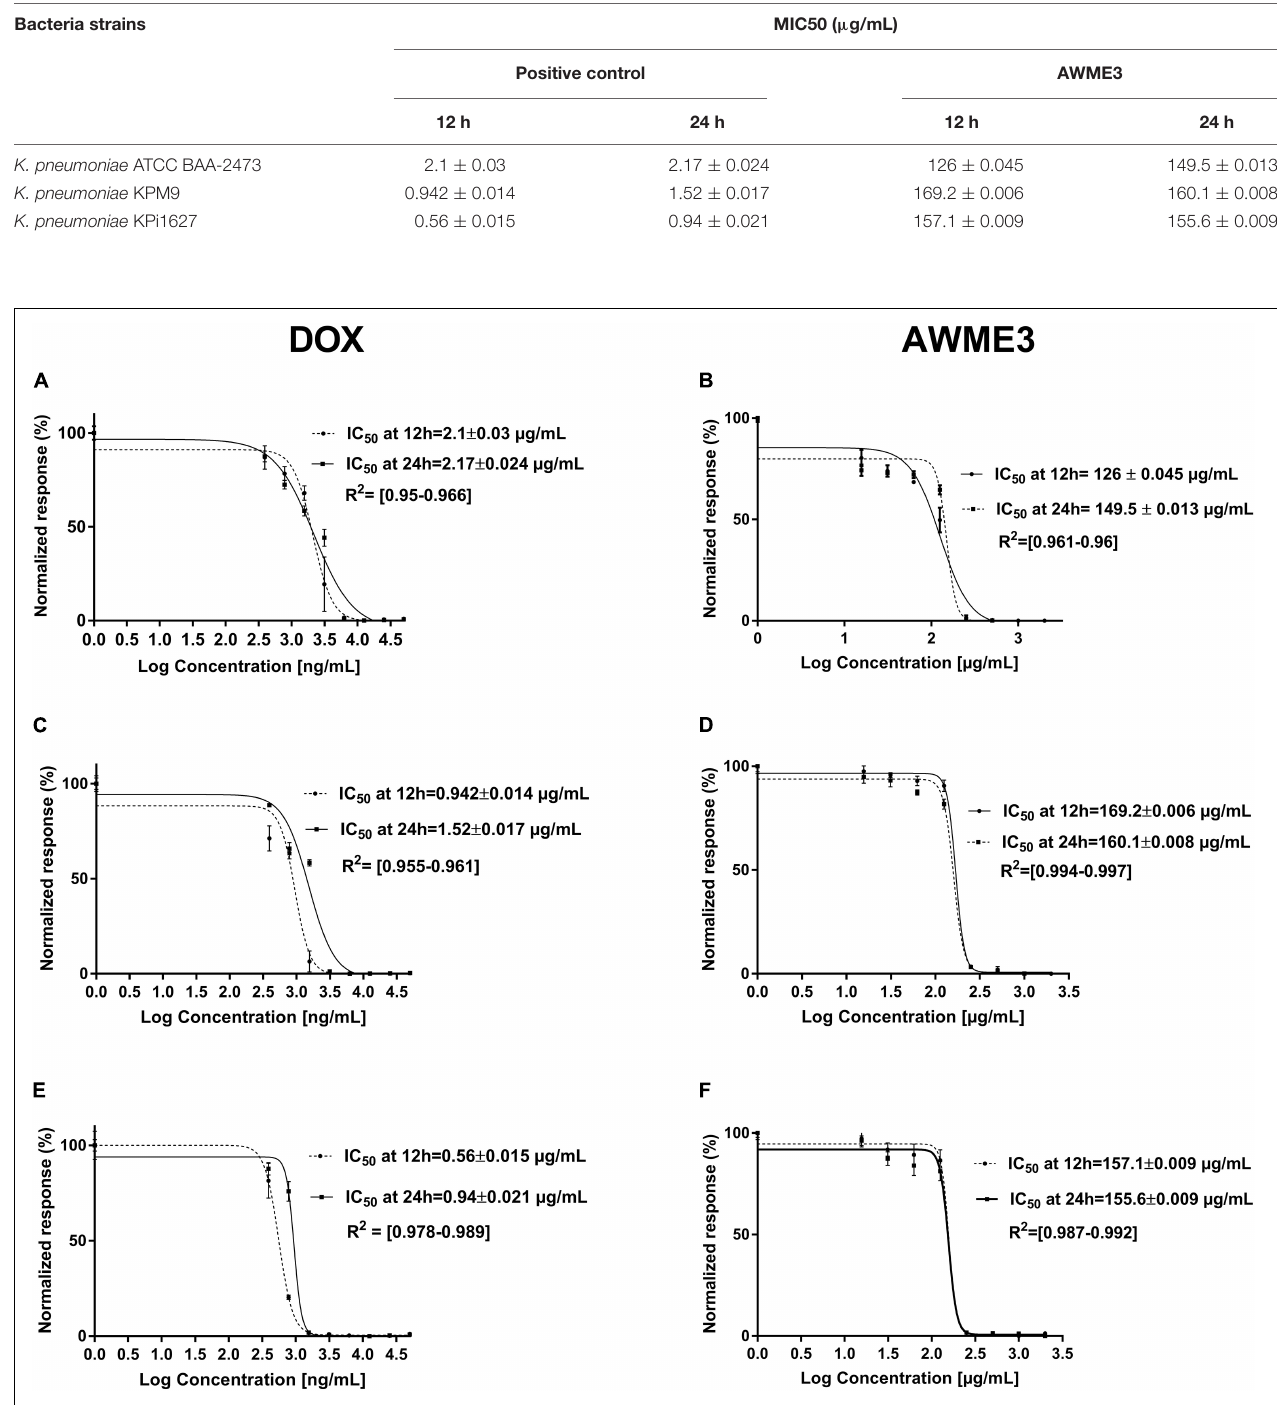
FIGURE 3 | The MIC 50 (IC 50 value in the figure legends) of K. pneumoniae strains treated with AWME3 from the larvae fat compared to the doxycycline (DOX) as a positive control. The MIC 50 values were calculated based on the turbidimetric assay data and compared to the positive control (DOX). The planktonic bacteria turbidity was assessed for (A,B) K. pneumoniae ATCC BAA-2473; (C,D) K. pneumoniae KPM9; (E,F) K. pneumoniae KPi1627 strains at 12 and 24 h incubation with (A,C,E) DOX; (B,D,F) AWME3. The MIC 50 values were calculated using the non-linear regression mode of Graph pad Prism 7 (Graph Pad Software Inc., San Diego, CA, United States). The (IC 50 )MIC 50 values are the average of three independent experiments ± standard deviation error mean